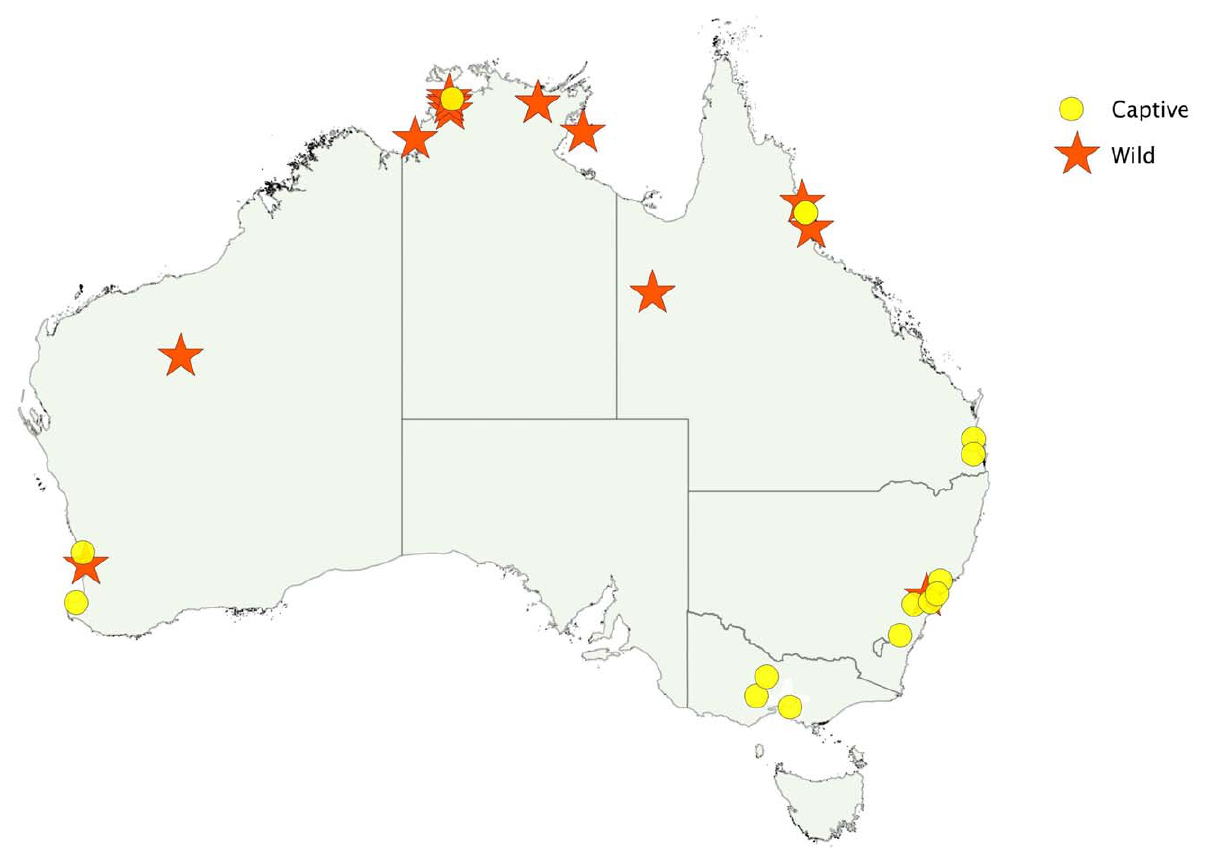
Figure 1. Geographical location of death adder bites, including bites by captive snakes (red star) and bites by snakes in the wild (yellow circle).